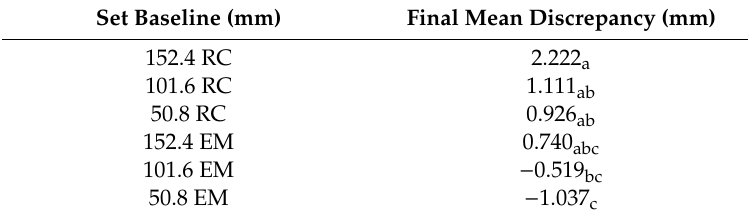
Table 6. LSD comparison of mean final discrepancies between set baseline value and the final hydraulic actuator position.